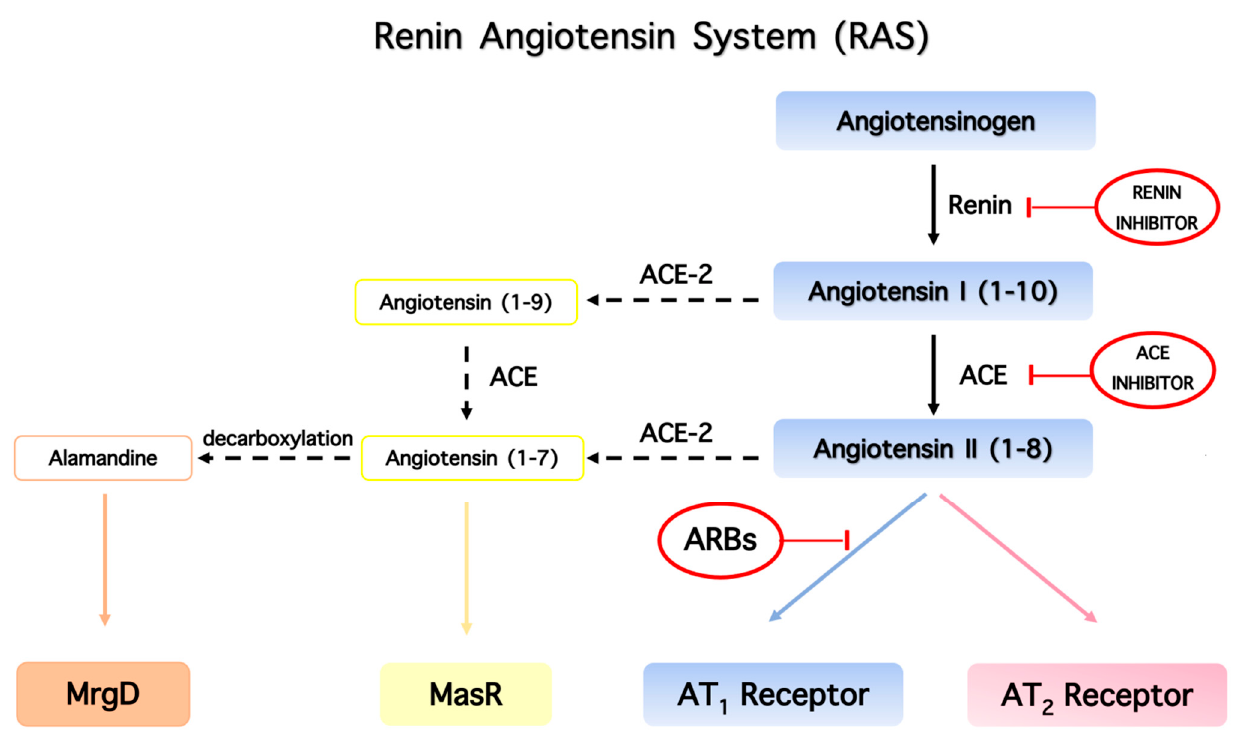
Figure 4. The main components of the renin–angiotensin system are the counterbalancing axes: ACE/ANGII/AT1R (vasoconstriction), ACE2/A(1–7)/AT2R/MasR (vasorelaxation), and ACE2/alamandine/MrgD (vasorelaxation).